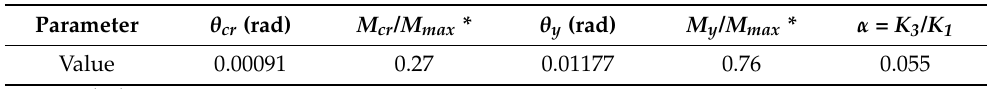
Table 1. Proposed moment–rotation values for fixed-end rotational spring to model beam–column member rigid-body rotational deformation